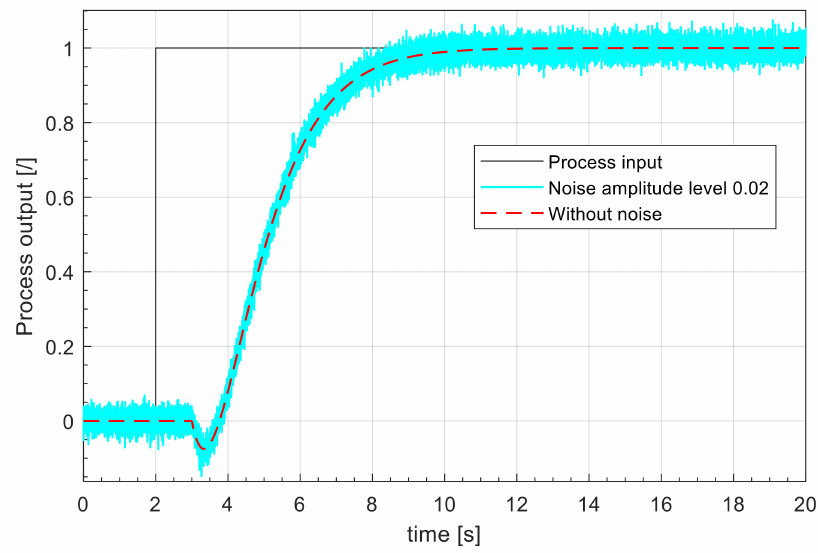
Figure 25. Typical step responses of process G P7 under noise gain value.